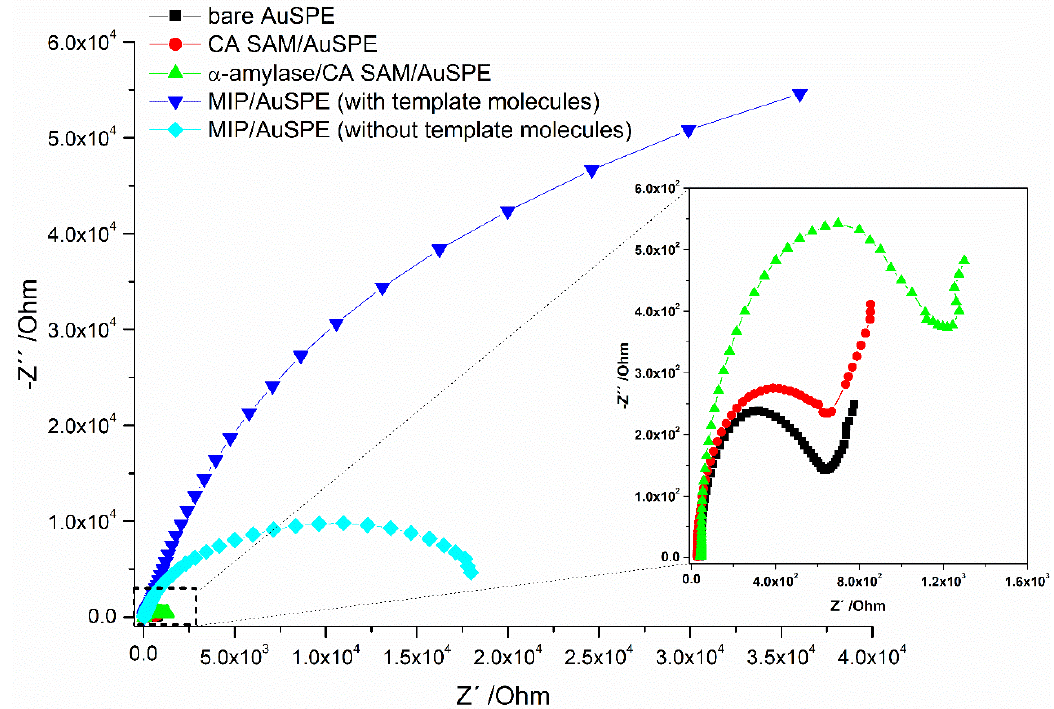
Figure 3. EIS data, collected in the presence of 5 mmol L − 1 [Fe(CN) 6 ] 3 − /4 − redox couple, during the step-by-step modification of the AuSPE surface to build the MIP sensing surface.